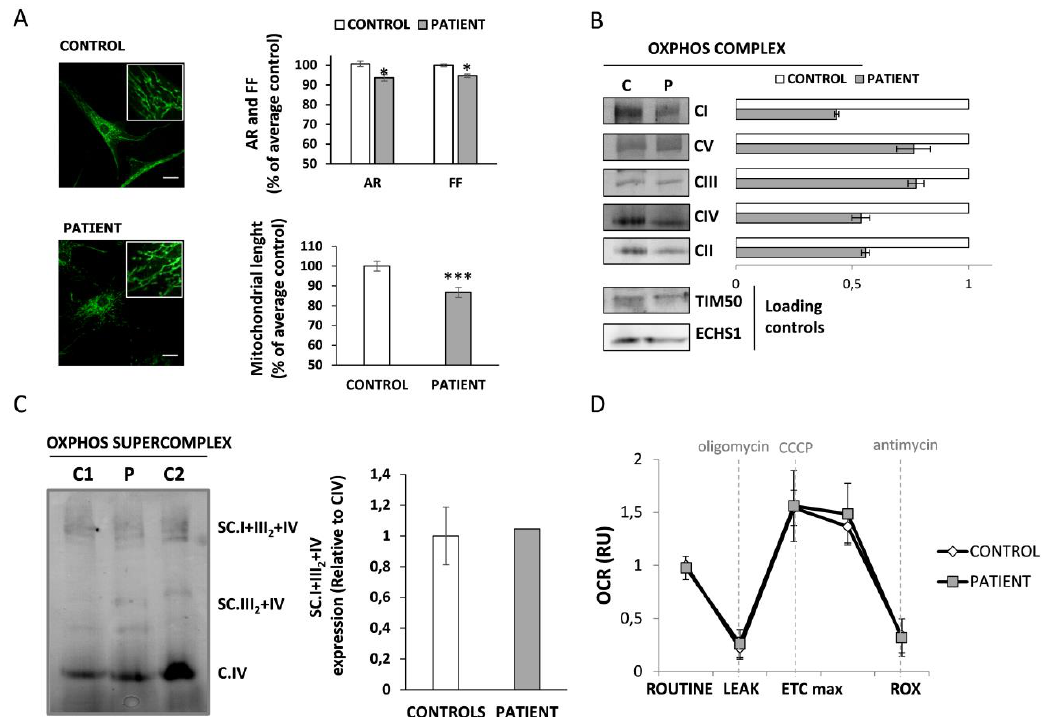
Figure 2. Mitochondrial function in HACE1 fibroblast. ( A ) Mitochondria morphology analysis was performed by immunofluorescence using TOM20 antibody as mitochondrial marker. Results showed a significant reduction in AR (Aspect ratio, indicative of morphology) and FF (Form factor, indicative of mitochondrial network branching) in patient fibroblasts. A significant reduction in the mitochondrial length was also observed in patient cells. A minimum of 70 cells were analysed for each sample. Scale bar, 30 µ m. * p < 0.05, *** p < 0.001. ( B ) Blue Native-PAGE studies and densitometry analysis of OXPHOS complexes showed a partial reduction in the assembly of all complexes in HACE1 patient fibroblasts. The expression of TIM50 (a mitochondrial membrane protein) and ECHS1 (a mitochondrial matrix protein) were used as mitochondrial loading controls. ( C ) Blue Native-PAGE studies followed by densitometry analysis showed no alterations in the assembly of mitochondrial respiratory chain supercomplexes in HACE1 fibroblasts. ( D ) High resolution respirometry analysis showed no di ff erences in the oxygen consumption rate between HACE1 and the control cells. Oxygen consumption rate at basal state (ROUTINE); residual oxygen consumption after oligomycin treatment (LEAK); maximum oxygen consumption induced by carbonyl cyanide 3-chlorophenylhydrazone (CCCP) titration (ETCmax); residual oxygen consumption after antimycin A treatment (ROX). Oxygen consumption rate (OCR) was measured as pmol / (second * millions of cells). The data is expressed as relative units (RU) of control cells.